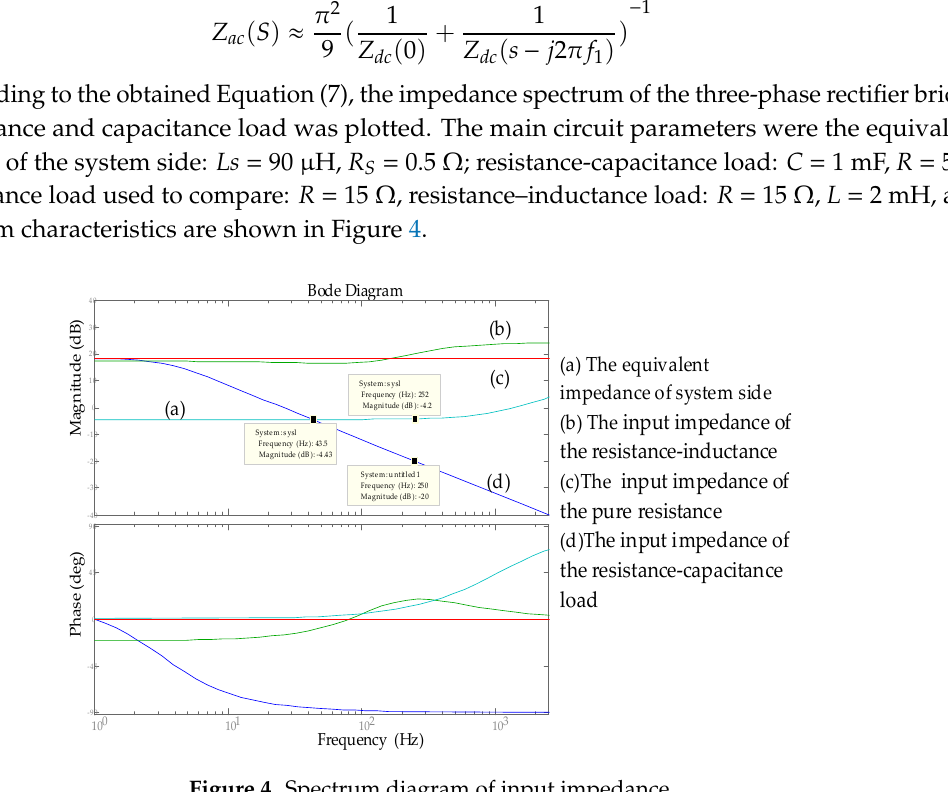
Figure 4. Spectrum diagram of input impedance.